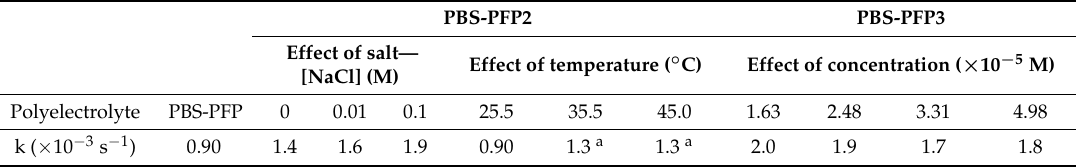
Table 3. Pseudo-first-order rate constants for the aggregation process of PBS-PFP (3.46 × 10 − 5 M), PBS-PFP2 (1.06 × 10 − 5 M when studying the effect of salt and 2.62 × 10 − 5 M when studying the effect of temperature) and PBS-PFP3 (various concentrations indicated in the table). All concentrations are given in terms of CPE repeat units.